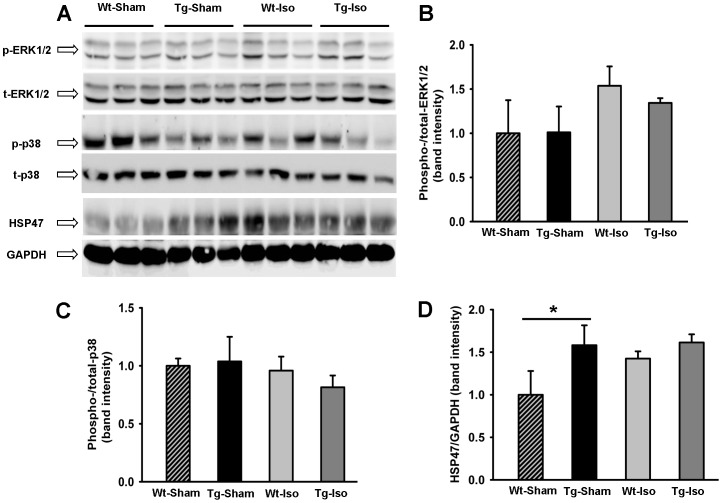
Western blot of ERK1/2, p-38 and HSP47.
A) Western blot of the expression of ERK1/2, p-38 and HSP47 proteins from hearts of Tg and Wt mice with and without ISO treatment. B) Quantification of the ratio of phospho−/total Erk1/2 from hearts of Tg and Wt mice with and without ISO treatment. C) Quantification of the ratio of phospho−/total p-38 from hearts of Tg and Wt mice with and without ISO treatment. D) Quantification of the HSP47 protein expression from hearts of Tg and Wt mice with and without ISO treatment. * P<0.05, Wt vs. Tg.